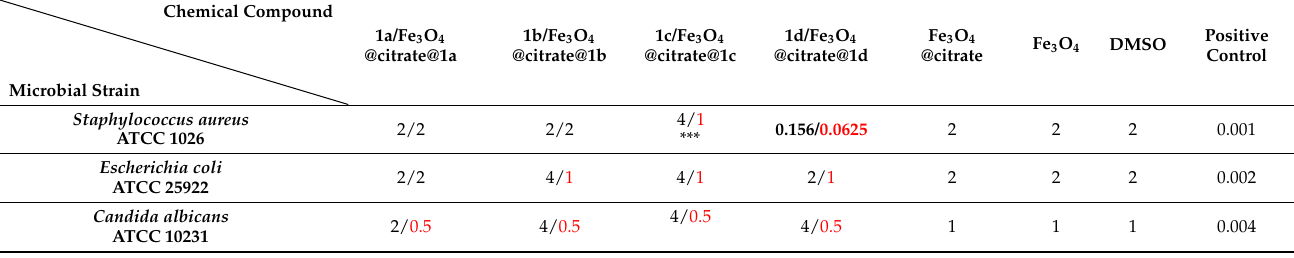
Table 1. Results of quantitative testing of antimicrobial activity against planktonic microbial strains and corresponding MIC values (mg/mL).